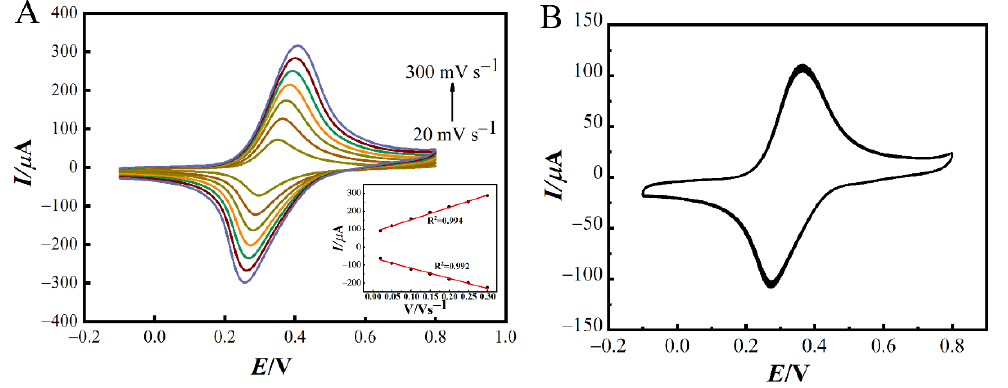
Figure 5. ( A ) CV curves of AuNPs/NiHCF-NPs/Zn/Fe-ZIF-NPC/GCE in 0.1 M PBS at various scan rates (from the inside to out: 0.02, 0.05, 0.10, 0.15, 0.20, 0.25 and 0.30 V s −1 ), (Inset: the relationship between the peak current and scan rate), ( B ) CV curves of AuNPs/NiHCF-NPs/Zn/Fe-ZIF- NPC/GCE in 0.1 M PBS at 0.05 V s −1 . The modification conditions are the same as in Figure 3.